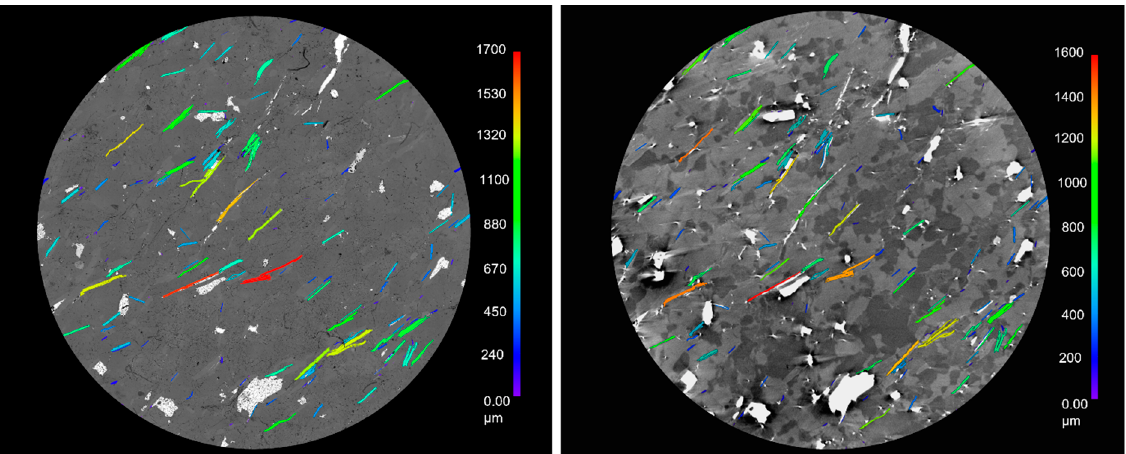
Figure 12. Segmentation result of the CT volume topmost slice ( A ) and the stitched OM image ( B ). The rainbow-coloured scale shows the distribution of the longest axis of the individual flakes.